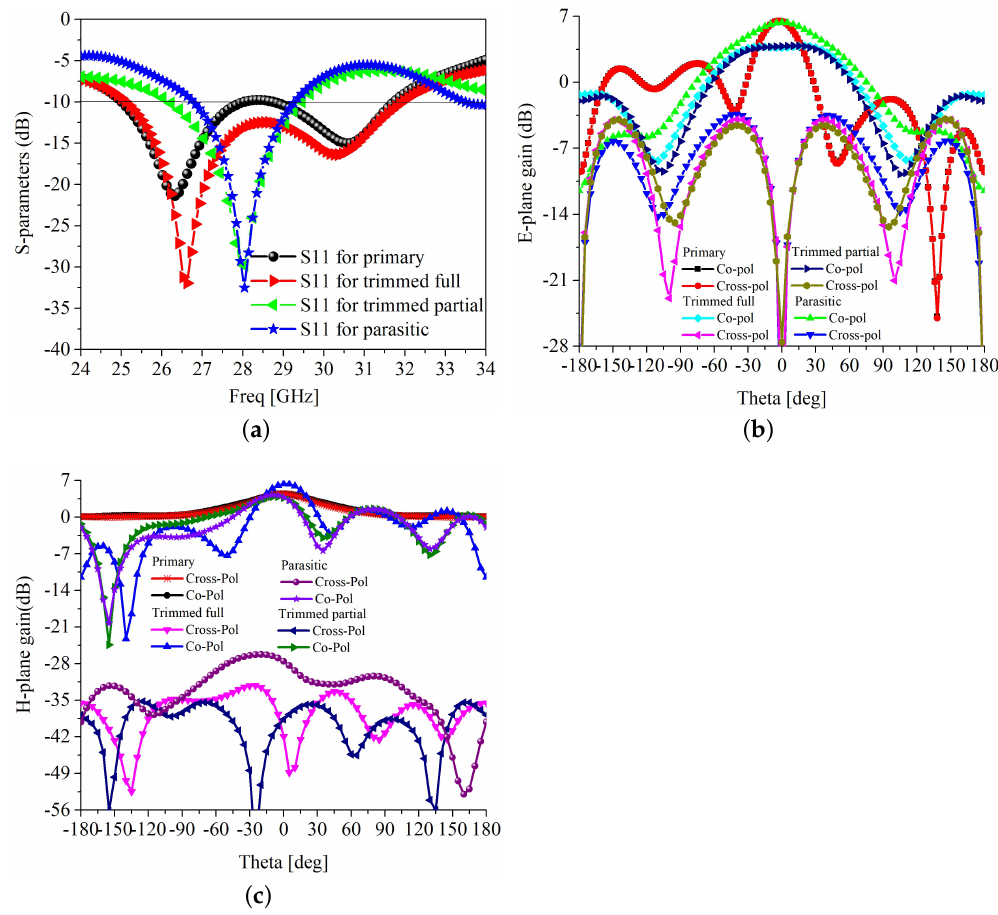
Figure 3. Antenna characteristics of different iterations ( a ) S 11 ( b ) E-plane ( c )